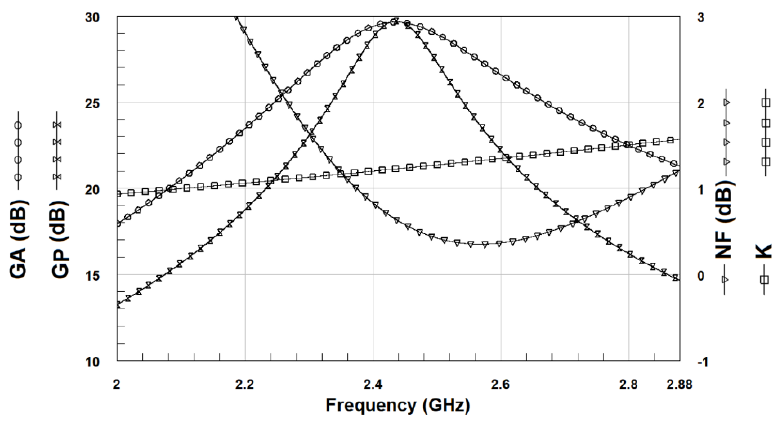
Figure 17. LNA power gain ( G P ), available power gain ( G A ), noise figure ( NF ), and stability factor ( K ) (simulation results).